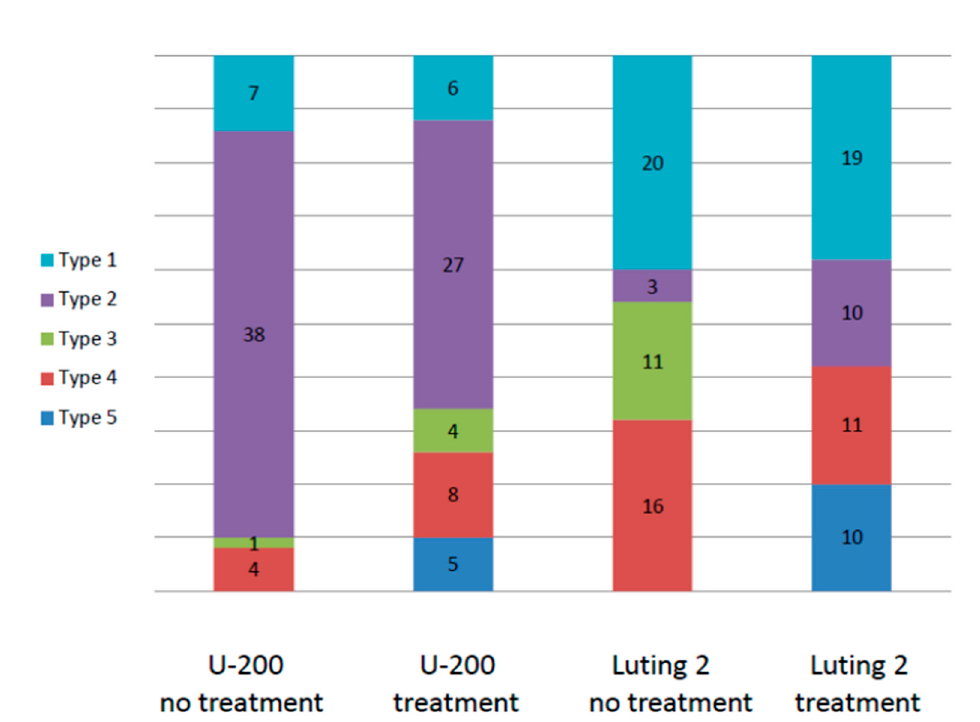
Table 1. Means (SD) of the retentive strength (MPa) of the zirconium-oxide crowns for all cementation groups.